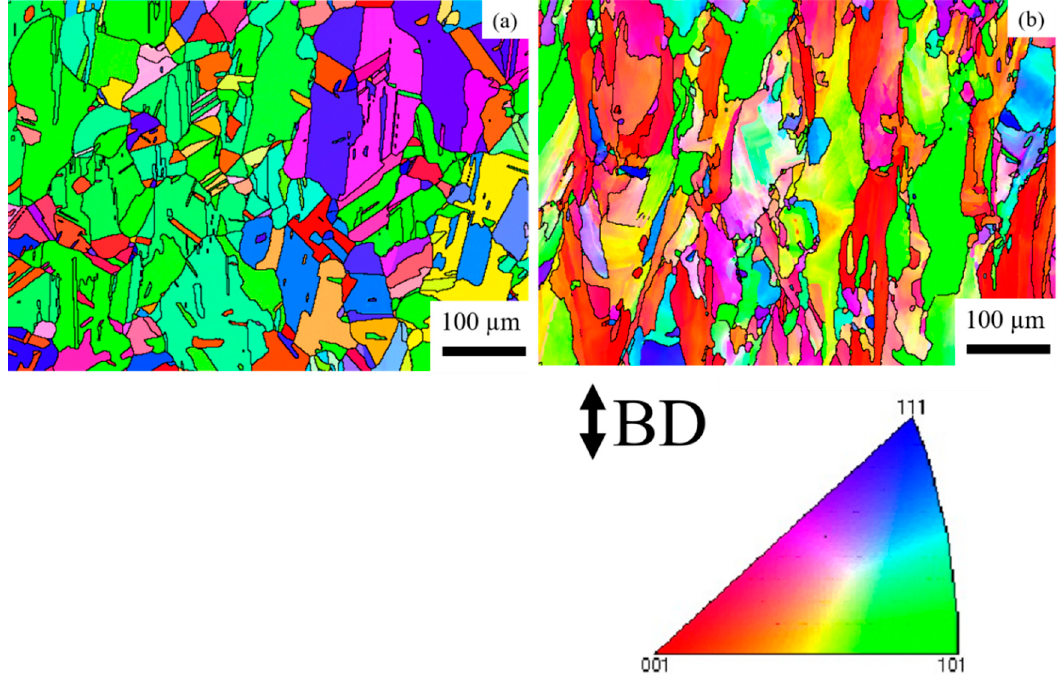
Figure 8. Inverse pole figure (IPF) maps of the ST specimens ( a ) HX and ( b ) HX-a.